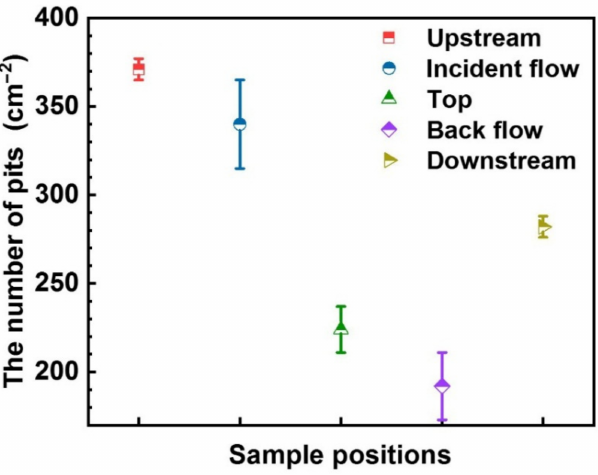
Figure 10. OM corrosion morphologies of the samples on ( a ) upstream surface, ( b ) incident flow surface, ( c ) top surface, ( d ) backflow surface, and ( e ) downstream surface of the WRH without corrosion products after 6 h flow corrosion.